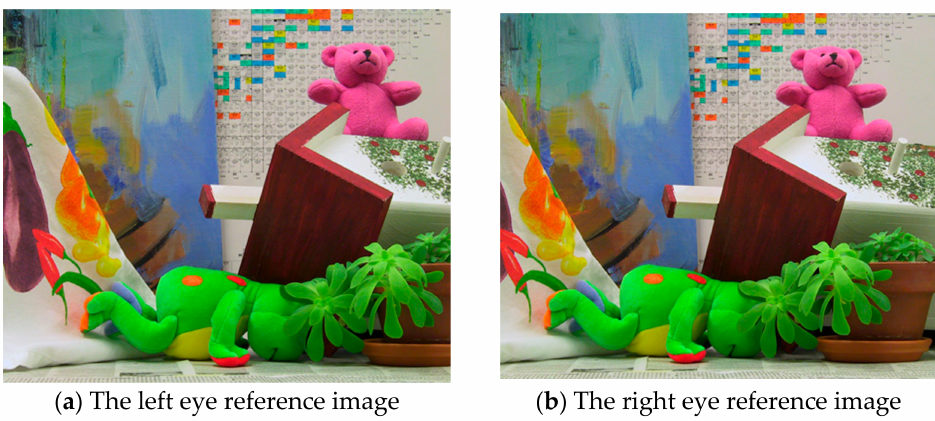
Figure 15. The left and right eye reference image of binocular original image.